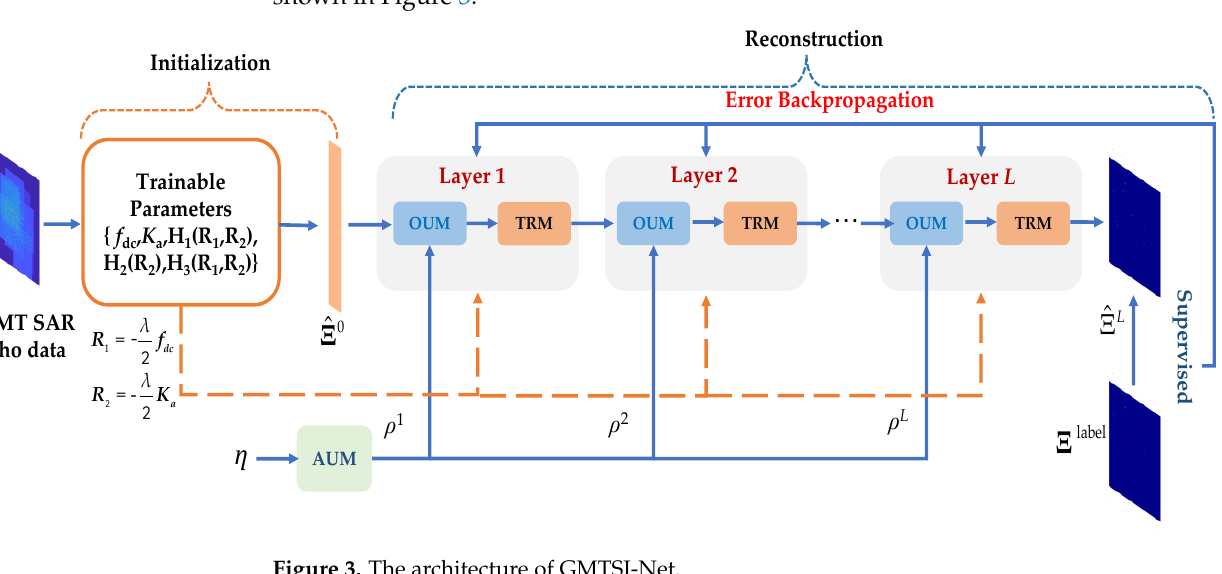
Figure 3. The architecture of GMTSI-Net.